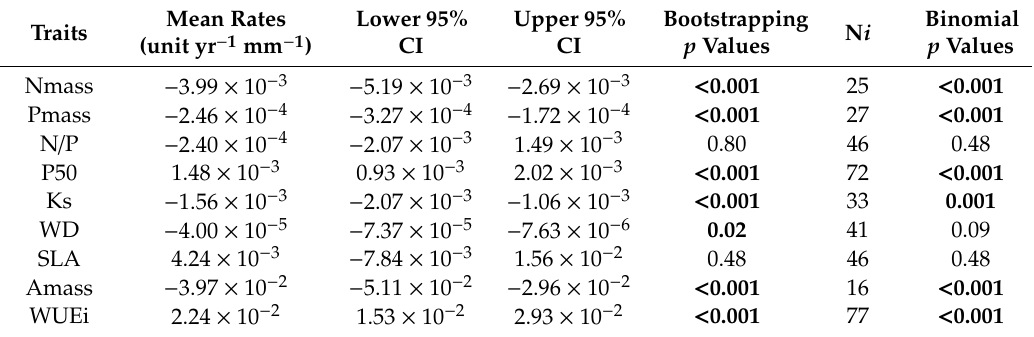
Table 2. Mean linear slope of regression in annual rates of change in quadrats’ functional composition vs. SW (dry season soil water content in the top 50 cm layer) in DHS plot. Mean Traits